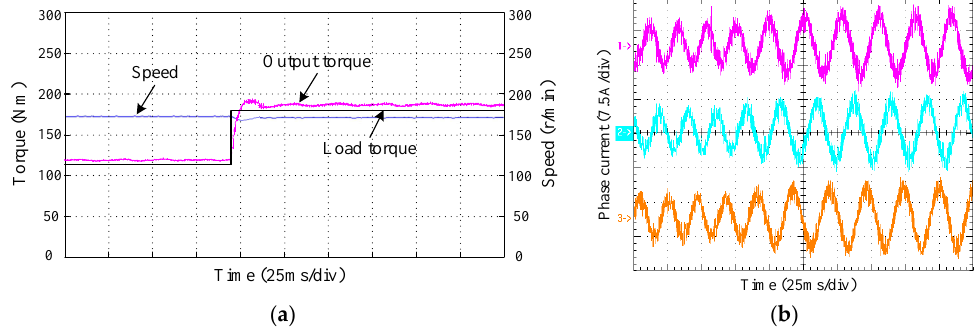
Figure 13. Performance characteristics of the prototype machine with sudden increased load at the rated speed. ( a ) Output torque and speed variations; and ( b ) three-phase current variation.